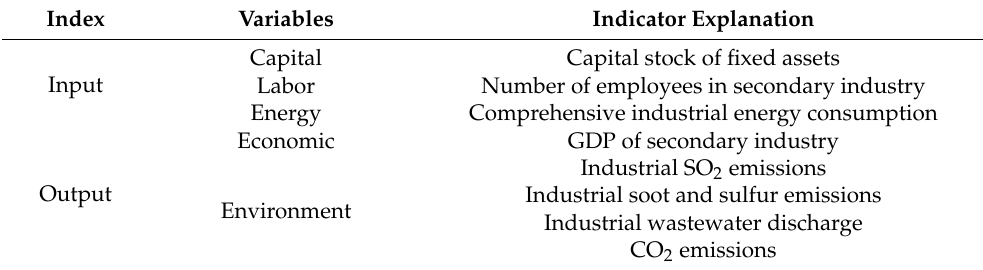
Table 3. Input–output indicator system of energy eco-efficiency in the